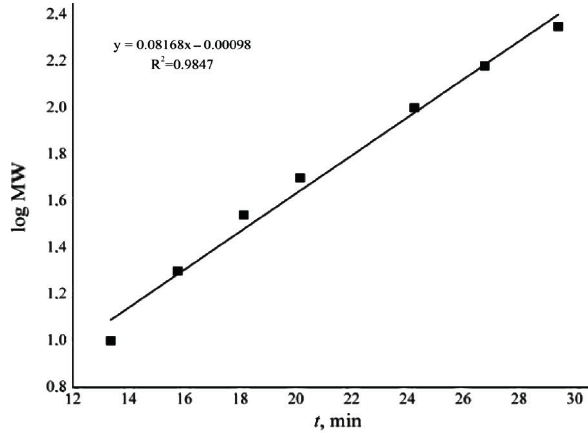
Figure 2 Calibration curve obtained as the ratio of the loga- rithm of molecular weight and migration times of known proteins separated by capillary gel electrophoresis